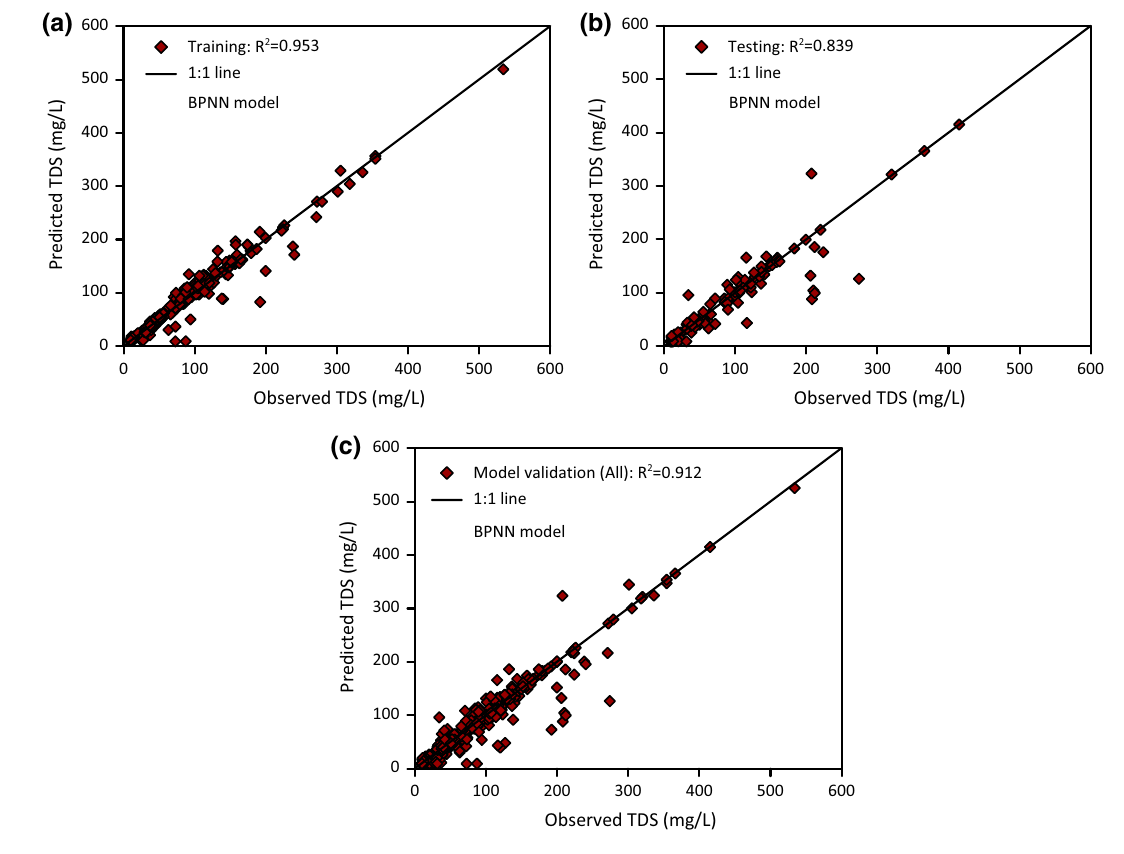
Fig. 5 Prediction accuracy of BPNN model for: a training; b testing; and c